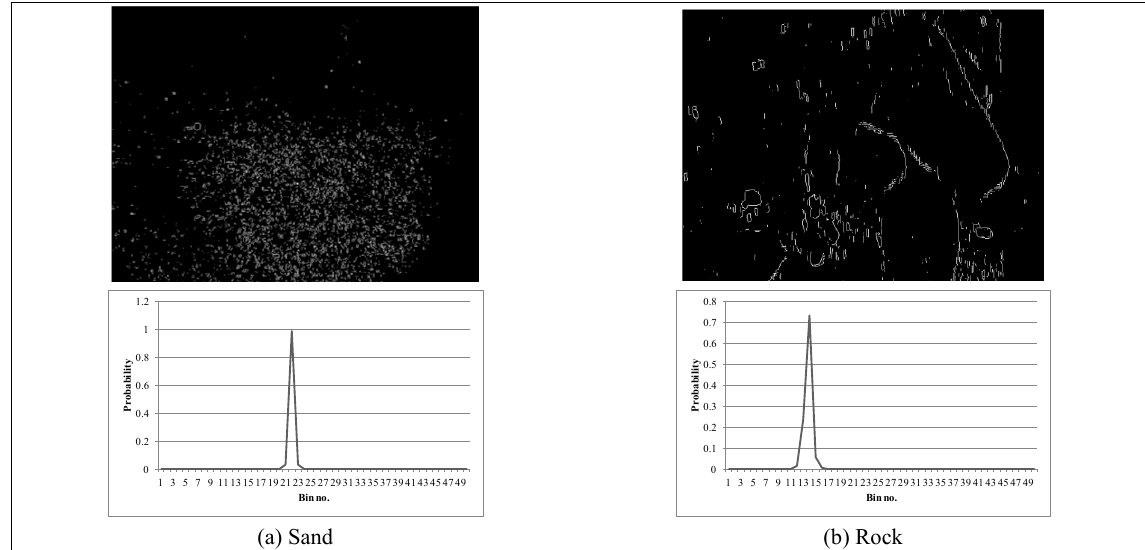
Fig. 5. Edge Feature– top row : edge structure and bottom row : DCT of edge image.